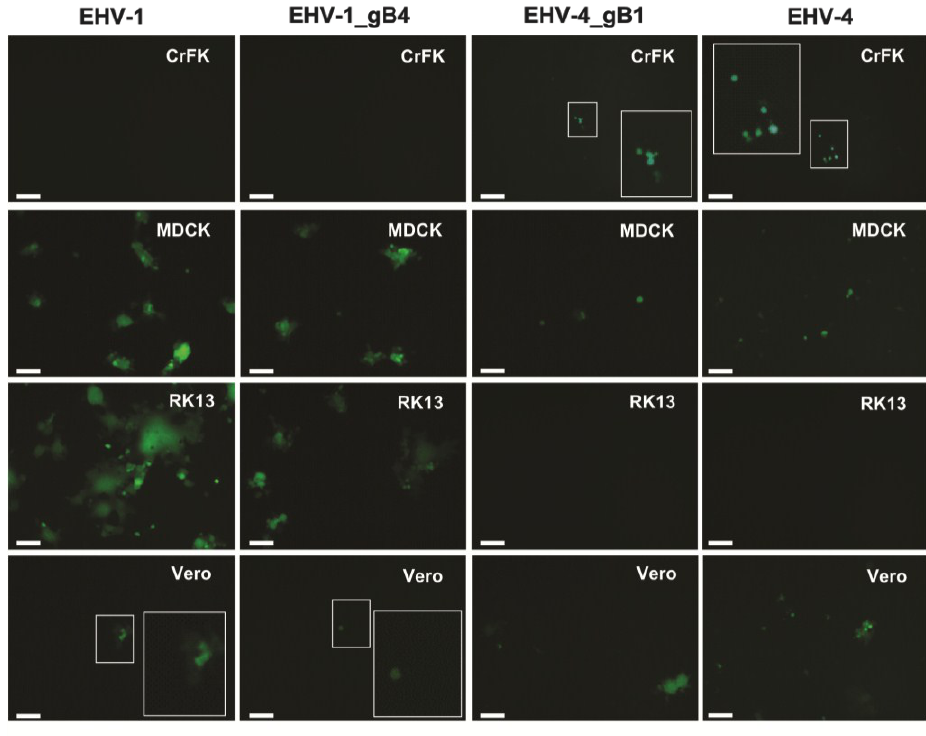
Figure 6. The role of gB in EHV-1 cellular tropism. Chinese hamster ovary (CHO)-K1, CHO-A, CHO-B, CHO-C, Crandell feline kidney (CrFK), Madin-Darby canine kidney